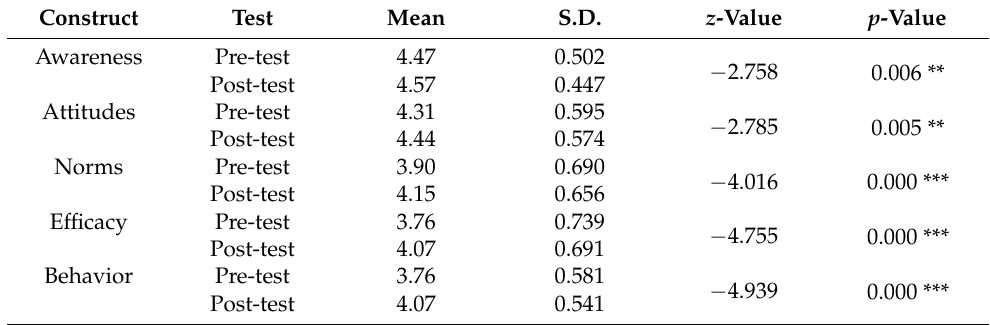
Table 6. Wilcoxon signed-rank tests between pre- and post-test for the Experimental